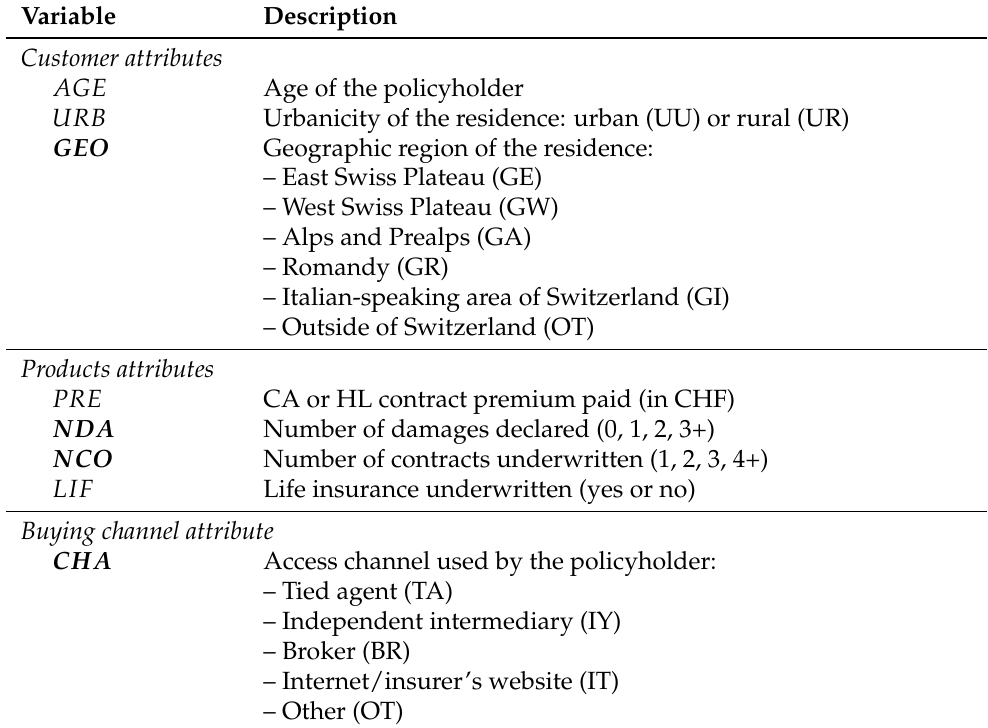
Table 1. Summary of the variables available in the